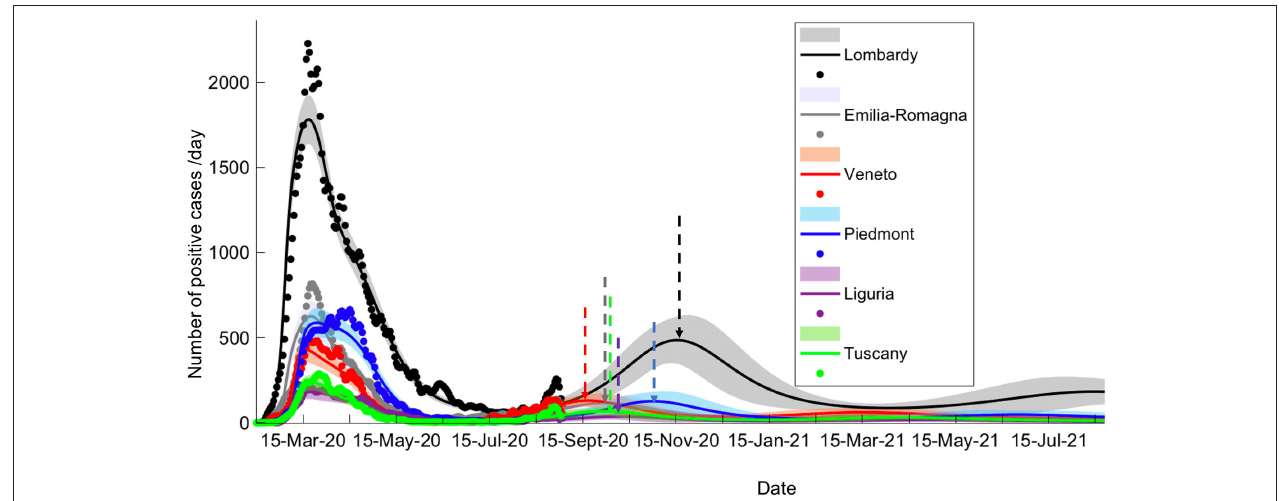
FIGURE 1 | Long-term prediction following BMC. Comparison of data fitting and prediction for the six regions under consideration, obtained via a BMC of 32 models for each region on dataset 2 (similar results could be obtained with dataset 1; see Methods for specification on datasets). Dots represent data on daily positive cases reported by the “National Civil Protection Agency.” Data are averaged with a sliding window of 7 days. The lines reproduce posterior expectations with corresponding 90% Bayesian confidence bands (shaded). Note the different timings of the peak of the second wave and its relative intensity in the different regions. Vertical dashed arrows indicate the peak of the second wave for each prediction.